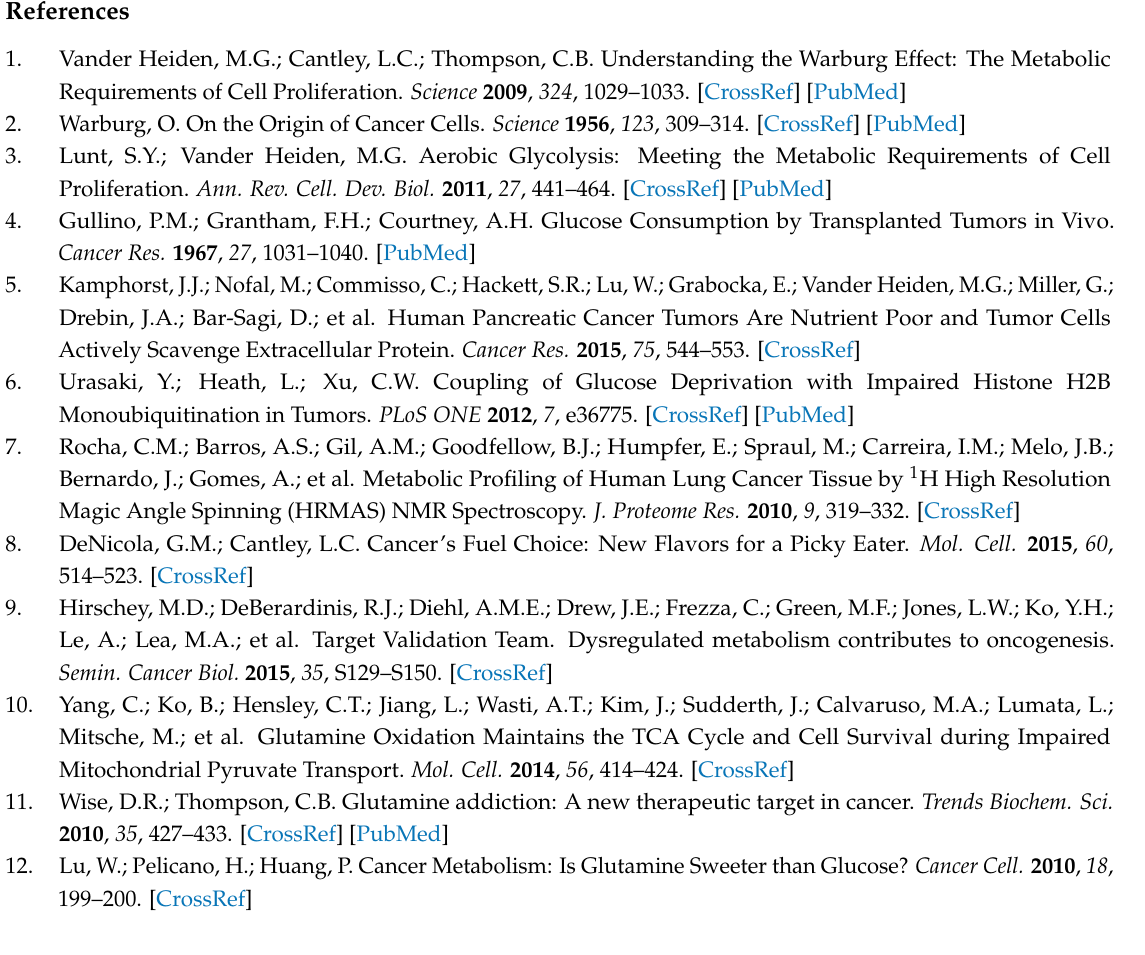
Figure S1: FITC-dextran uptake in glucose independent and glucose addicted cells., Figure S2: Inhibition of macropinocytosis by EIPA, Figure S3: Inhibition of macropinocytosis by EHT 1864, Figure S4: Rac signaling and macropinocytosis is not regulated by glucose, Figure S5: Rac1 regulates macropinocytosis of H1975 cells in a PAK dependent manner to promote glucose independence, Figure S6: Rac1 activation of Pak regulates macropinocytosis, Figure S7: Rac1 is required for tumor formation of glucose independent cells, Figure S8: PI3K activates Rac-mediated macropinocytosis, Figure S9: Co-localization of internalized Rhodamine-labeled yeast protein (red) with FITC-dextran (green) puncta in H1975 cells, Figure S10: Alanine generates TCA cycle and gluconeogenic intermediates, Figure S11: ALT2 is expressed in NSCLC cells and converts alanine to pyruvate to support glucose free